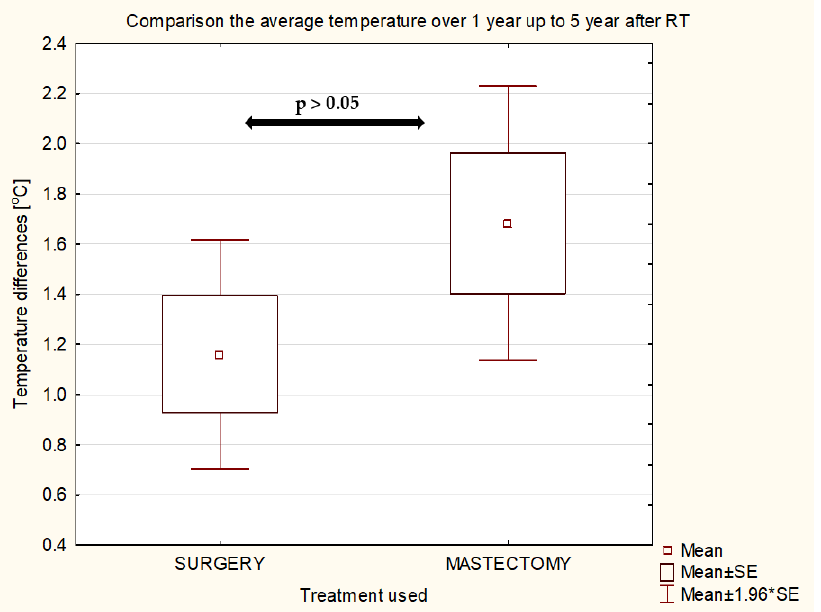
Figure 8. Comparison of mastectomy and surgery for the group of patients over 1 year and up to 5 years after radiotherapy. 5 years after